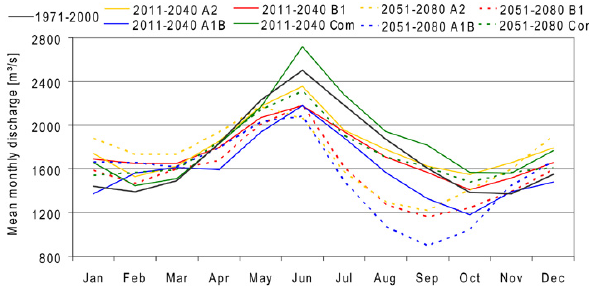
Figure 14. Developing of the mean monthly discharge in the UDRB for the past from 1971–2000 in comparison to the 30-years period from 2011–2040 and 2051–2080.